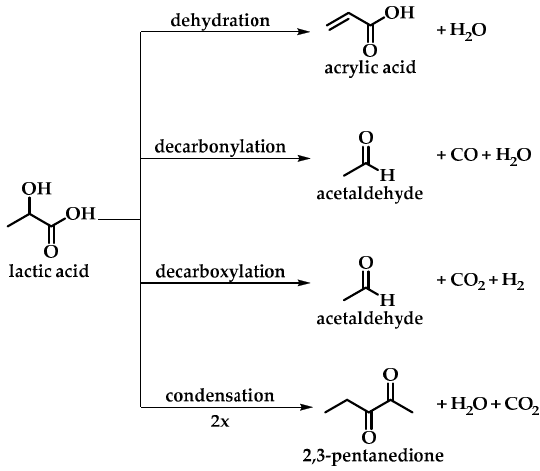
Figure 1. Conversion pathways of lactic acid. Decarbonylation and decarboxylation to acetaldehyde and condensation to 2,3-pentanedione, respectively, compete with the desired dehydration to acrylic acid [18].